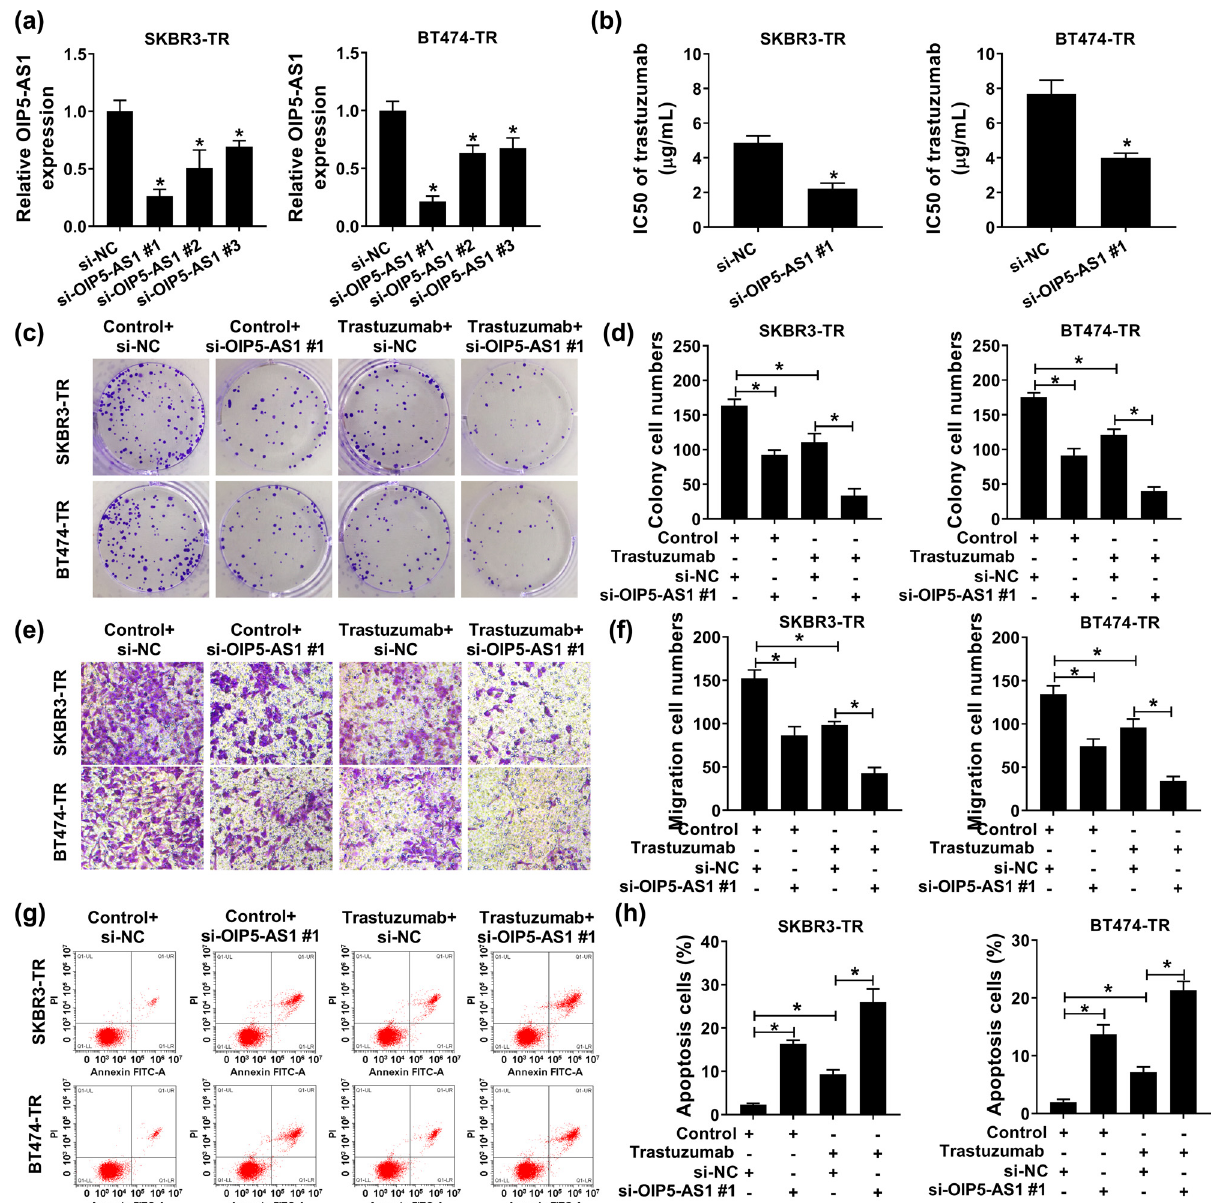
Figure 2: OIP5 - AS1 knockdown restores trastuzumab sensitivity in trastuzumab resistant breast cancer cells. SKBR3 - TR and BT474 - TR cells were transfected with si - OIP5 - AS1 or si - NC. After transfection, ( a ) qPCR analysis of OIP5 - AS1 expression; ( b ) CCK - 8 analysis of IC 50 values of resistant cells to trastuzumab; ( c and d ) colony formation analysis of resistant cell proliferation; ( e and f ) transwell analysis of resistant cell migration; ( g and h ) resistant cell apoptosis analysis with fl ow cytometry. * P < ( Figure 3d ) , indicating that OIP5 - AS1 presented in exo - somes. The treatment of SKBR3 - TR and BT474 - TR cells with GW4869, an inhibitor of the secretion of exosomes from cells, led to a reduction in the quantity of exosomes ( Figure 3e ) as well as OIP5 - AS1 expression ( Figure 3f ) . All these results indicated that extracellular OIP5 - AS1 was packaged into exosomes, which were also secreted by SKBR3 - TR and BT474 - TR cells.